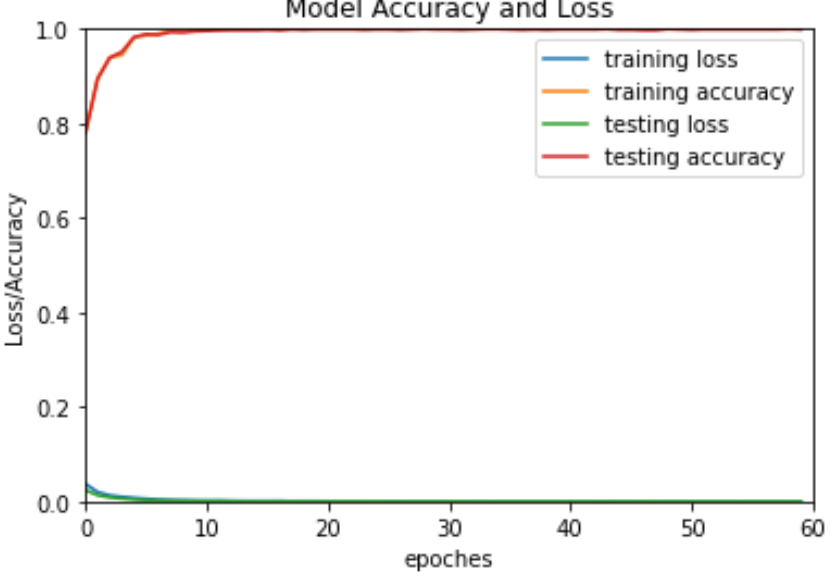
Figure 12. The training and testing loss curves and the corresponding accuracy curves versus the number of